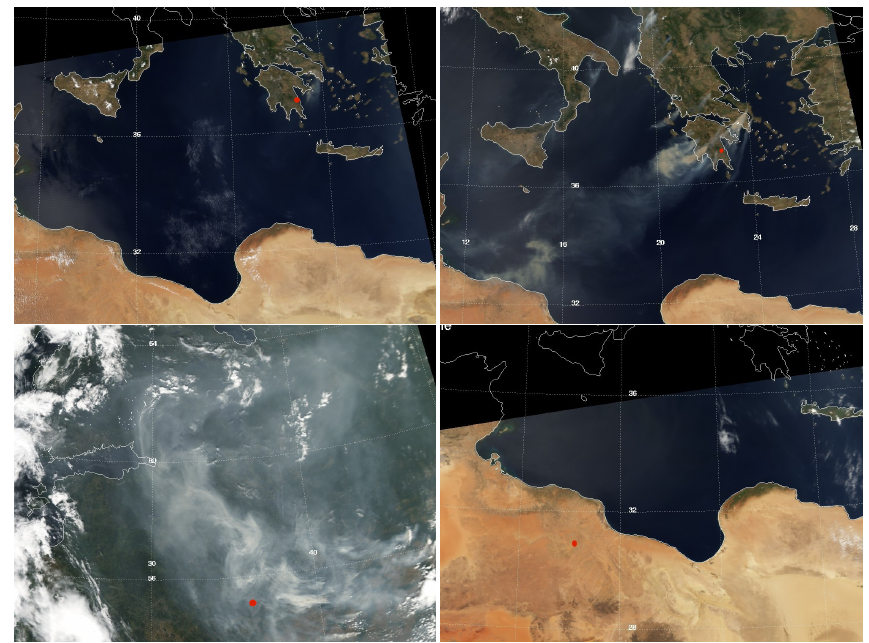
Fig. 9. MODIS true-colour images for the four example cases described in Sects. 5.1–5.3. Top left is Greece, 16 August 2007; top right is Greece, 25 August 2007; bottom left wildfires are in Moscow, 2010; bottom right is Sahara sandstorm, 2011. The approximate centre location of the OMI pixel is marked with small red dot.